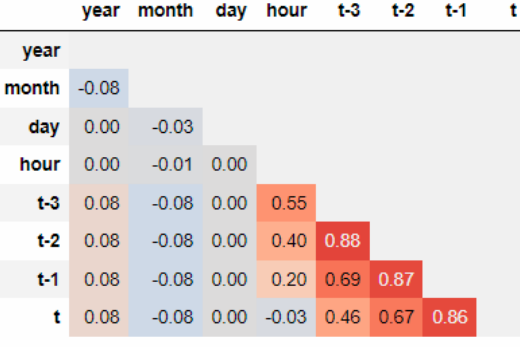
Figure 8. Correlation matrix of the dataset with the previous values.